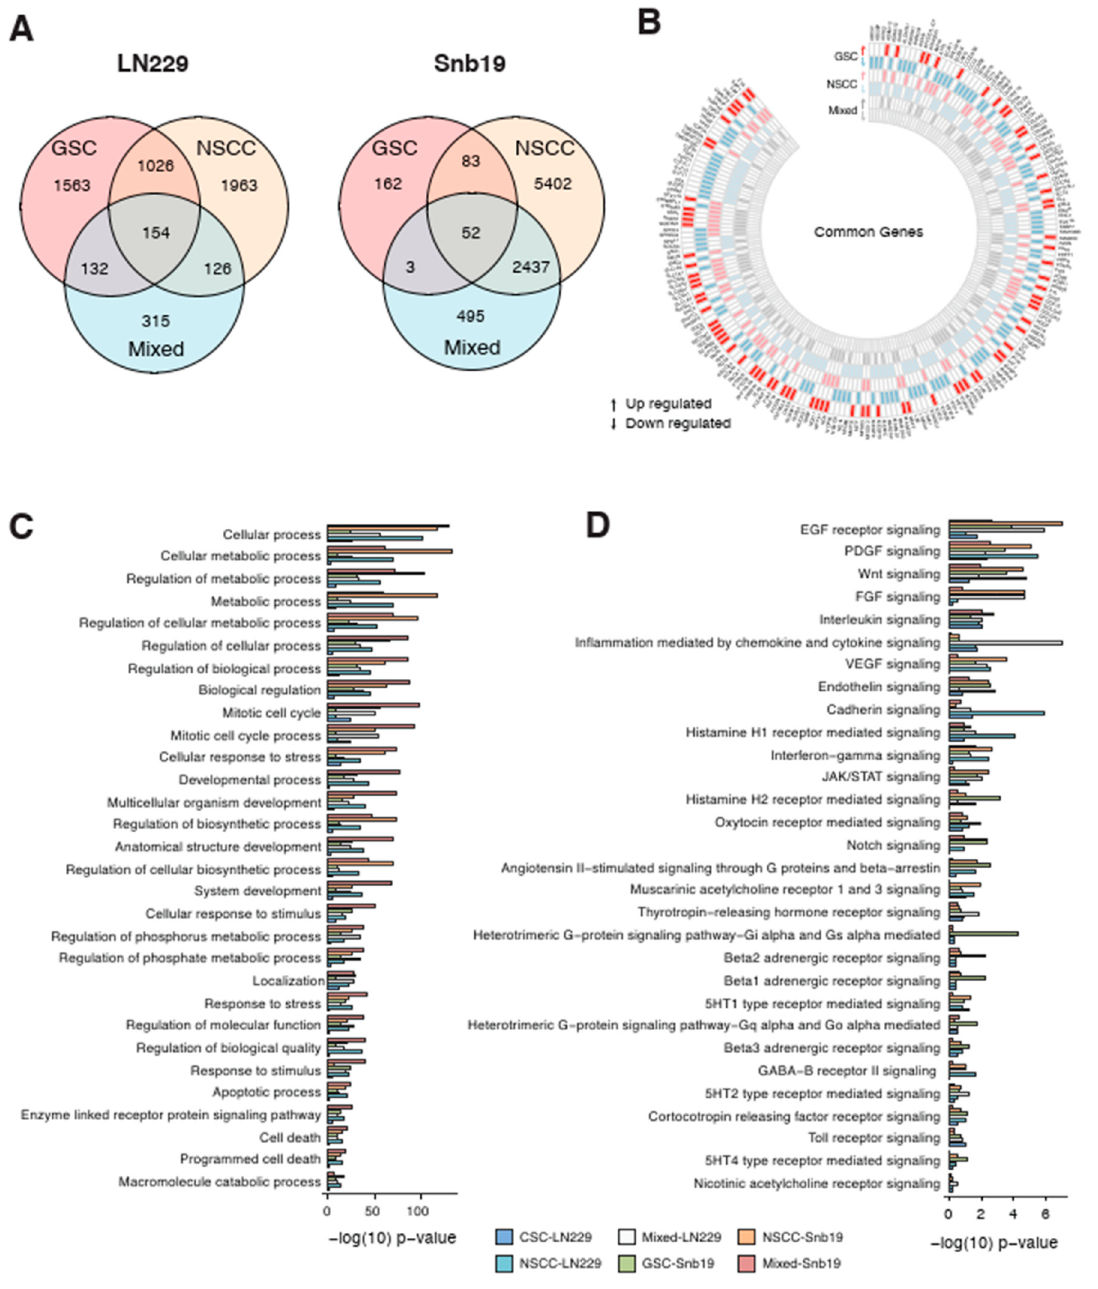
Figure 4. Effect of THTMP on GSC, NSCC and their progenitors gene expression patterns ( A ) Overlapping DEGs in GSC, NSCC and mixed populations of LN229 and SNB19 cell lines. ( B ) Circos plot of overlapping up- and down-regulated genes detected in GSC, NSCC and progenitor lines. ( C ) Common KEGG biological process in GSC, NSCC and progenitor lines. ( D ) Common signaling pathways in GSC, NSCC and progenitor lines.